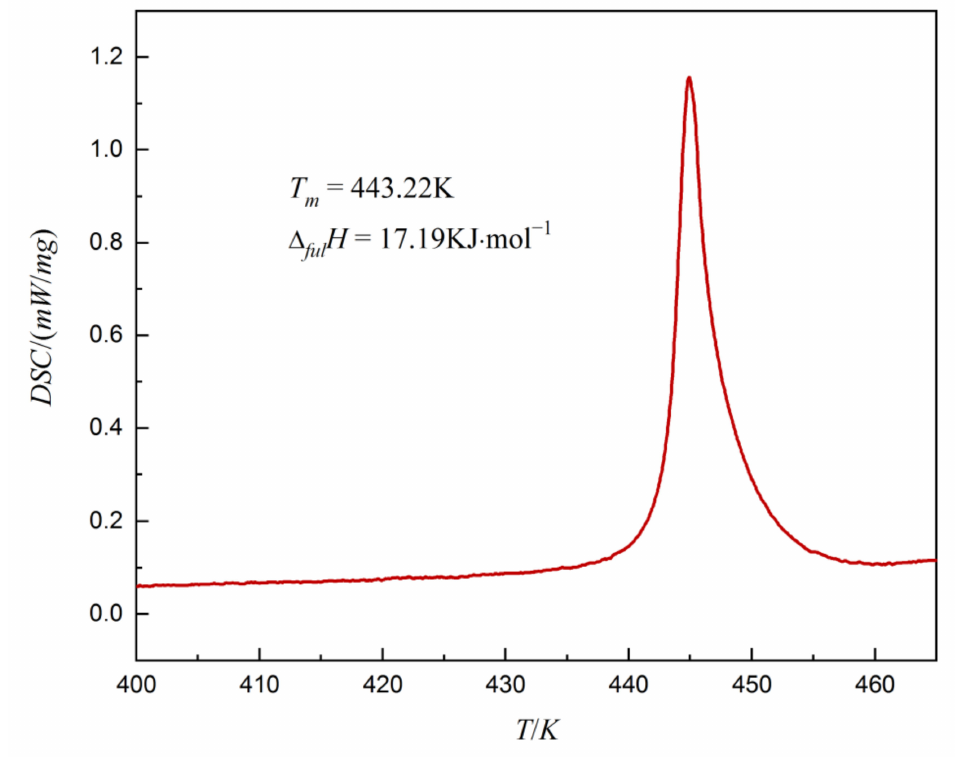
Figure 2. The differential scanning calorimetry (DSC) curve of dehydroabietic